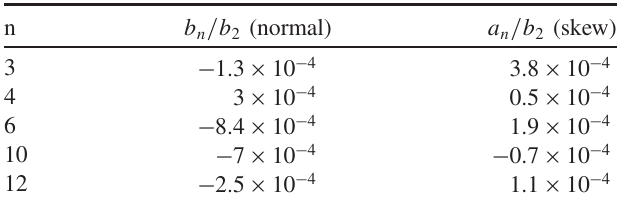
TABLE VI. Higher order integrated multipoles of the quadru- pole prototype, measured at 10 mm and expressed at 7 mm radius. The other multipoles are below 10 − 5 .